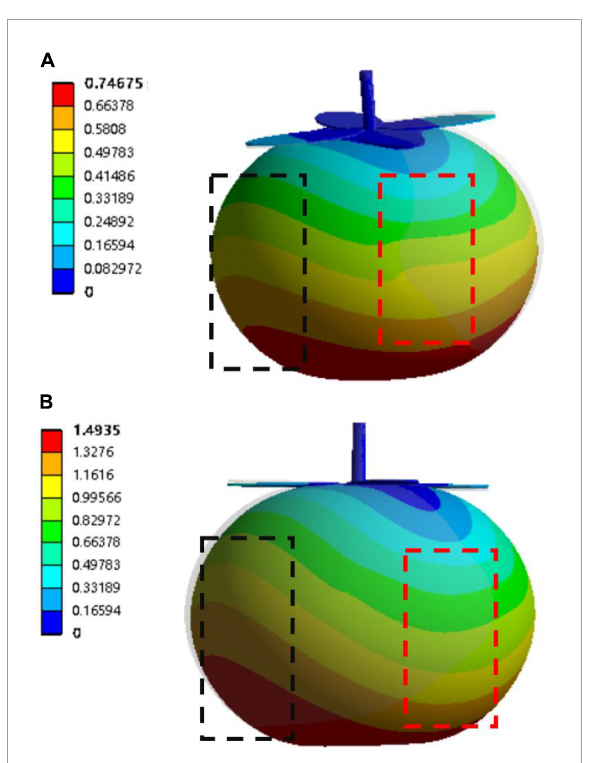
material properties of tomato are set as follows: elastic modulus: